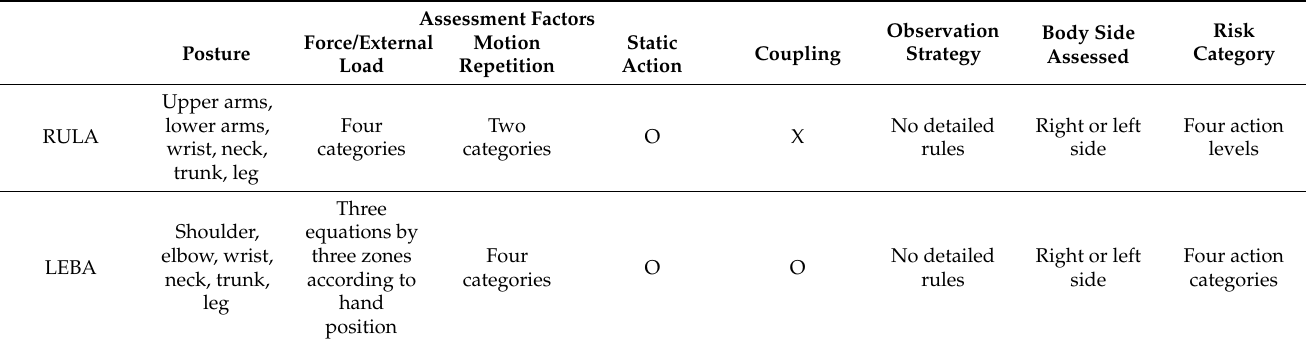
Table 1. General characteristics of the RULA and